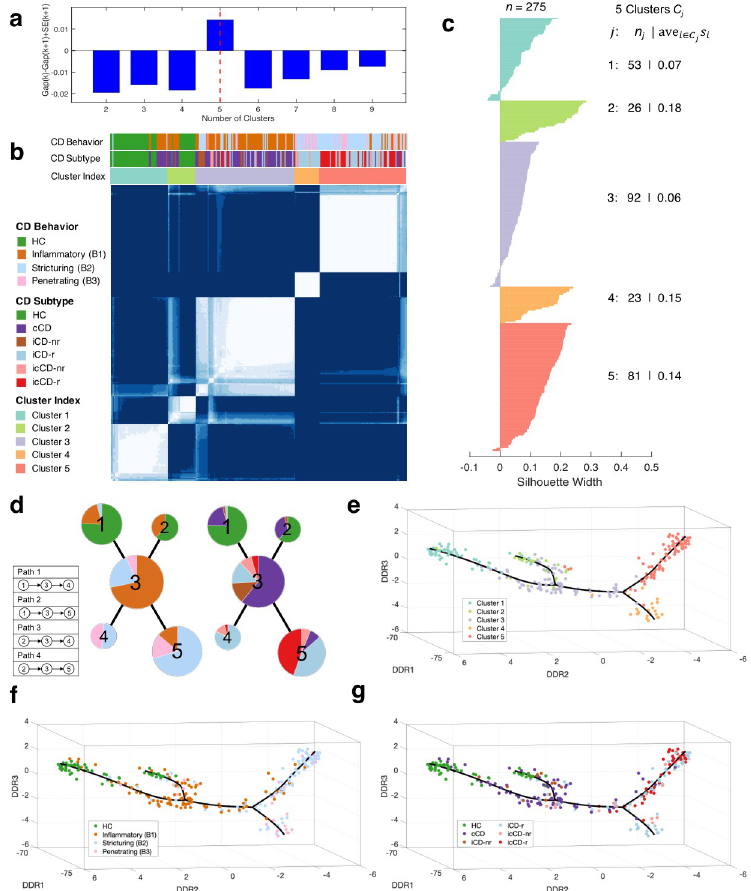
Fig 2. Microbial community dynamic analysis performed on a human gut microbiome dataset ( n = 275) obtained from a Crohn’s disease study. ( a ) The number of clusters was estimated to be five by gap statistic. ( b ) Resampling- based consensus clustering analysis identified five robust and stable clusters. ( c ) Silhouette width analysis further confirmed the robustness of clustering assignment. A total of 255 of 275 (93%) samples had a positive silhouette width, and the average was equal to 0.1. ( d ) By combining the principal-tree and clustering results, a microbial progression model of Crohn’s disease was constructed, and four progression paths were identified. Each node represents an identified cluster, and the pie chart in each node depicts the percentage of the samples in the node having one of the CD behaviors (left panel) or belonging to one of the CD subtypes (right panel). ( e - g ) Visualization analysis provided a general view of sample distribution supported by the selected microorganisms. Each point represents a sample, which was projected onto a three-dimensional space by using the DDRTree method. Each sample was color-coded by its cluster index ( e ), CD behavior ( f ), and CD subtype ( g ), respectively. The solid line represents the constructed principal tree. HC: healthy control, cCD: colonic Crohn’s disease, iCD: ileal Crohn’s disease, icCD: ilealcolonic Crohn’s disease, r/nr: with/without ileocaecal